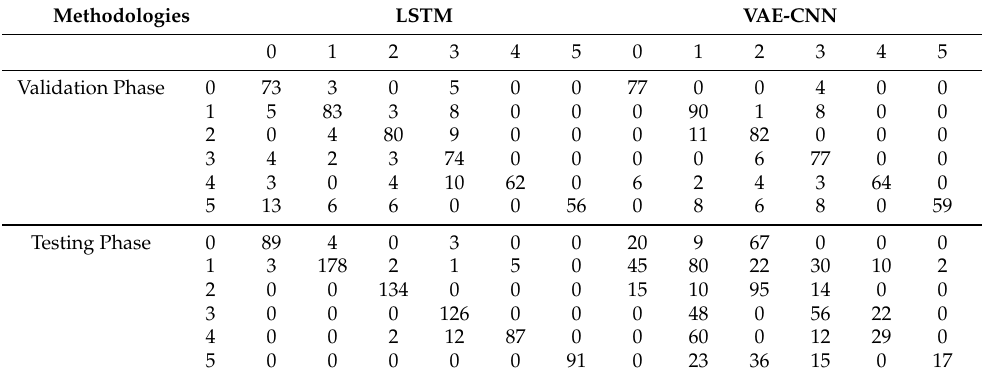
Table 5. Confusion matrix for validation and testing into six-class (type of regurgitation) classification.